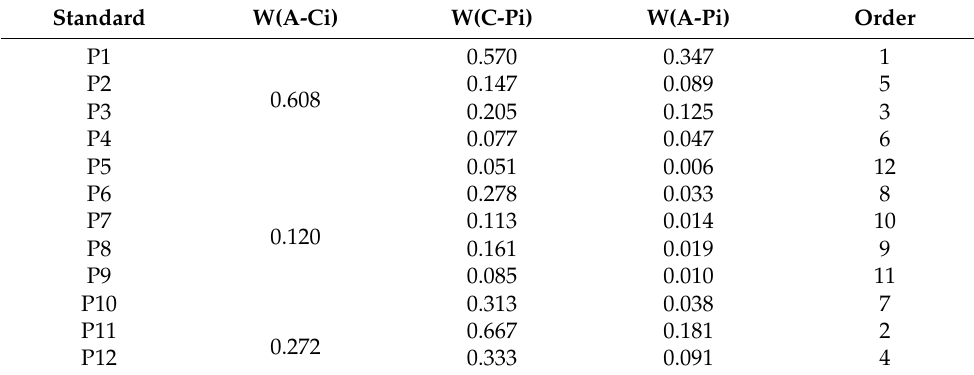
Table 11. The comprehensive weight value of each layer.